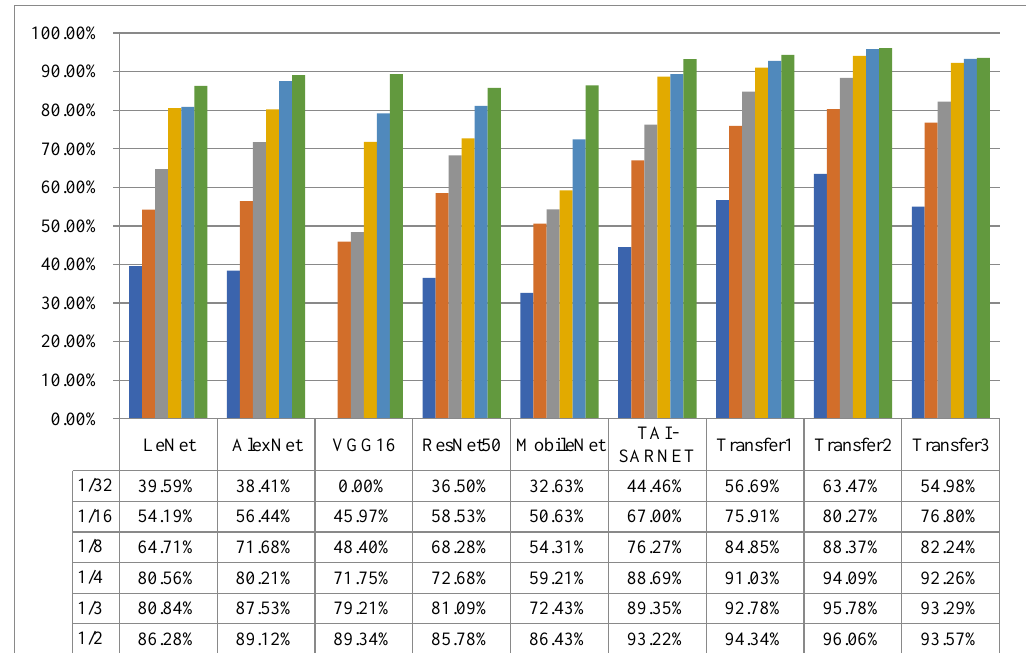
Figure 8. Result on state-of-the-art model on small samples.